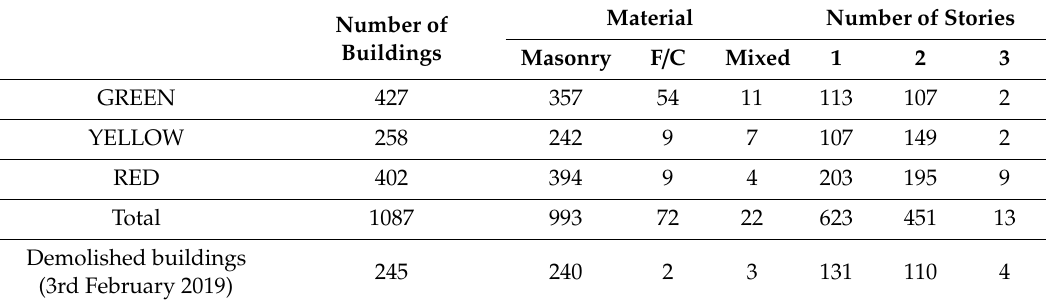
Table 2. Statistical information concerning the demolished buildings on 3rd February 2019.